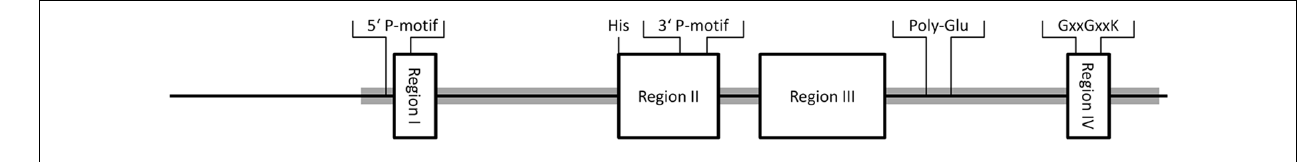
binding regions (5 (cid:2) P-motif, 3 (cid:2) P-motif, GxxGxxK), the proton acceptor histidine (His), and a poly-glutamic acid (Poly-Glu), that can be found in